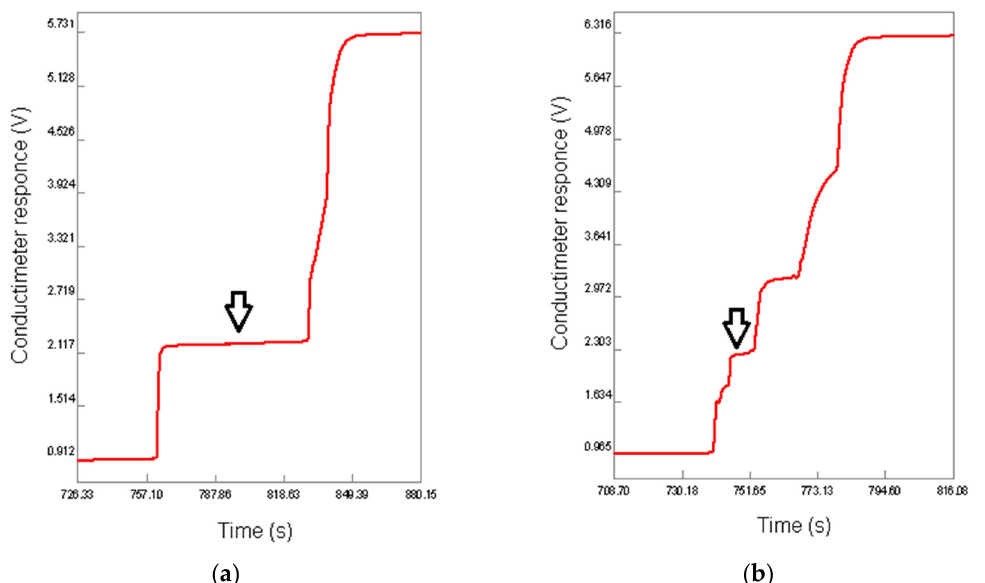
Figure 6. Isotachopherograms of the standard solution of hyaluronic acid ( a ) and supplement 1 ( b ). Arrow indicates the analyte zone.